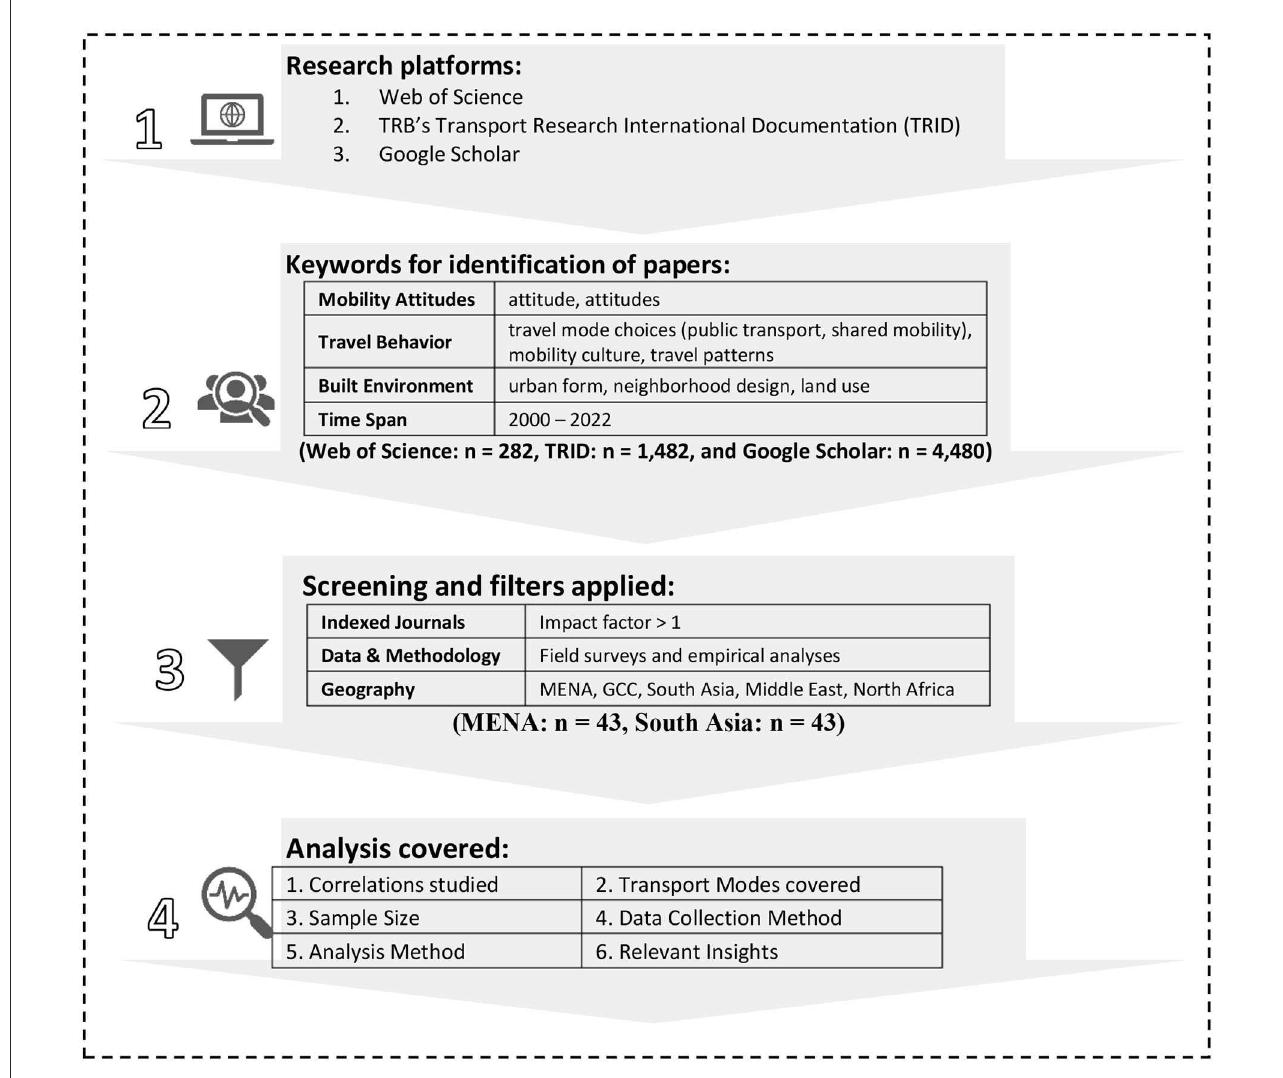
FIGURE1 Literature research review. Methodology adapted from PRISMA protocol (Moher et al.,